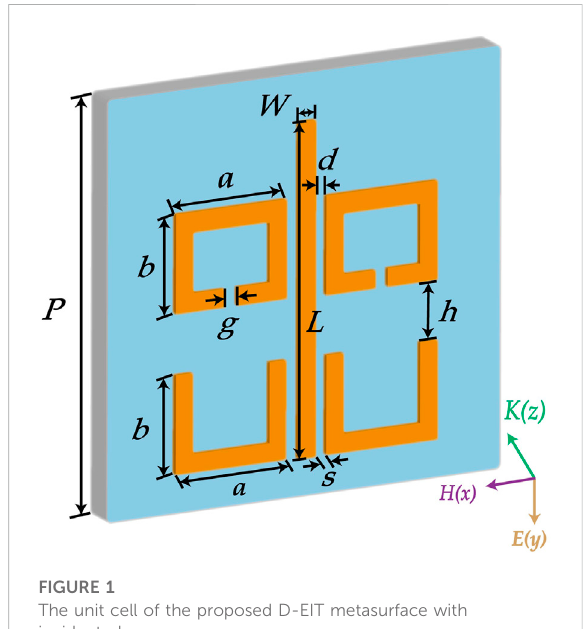
FIGURE 1 The unit cell of the proposed D-EIT metasurface with incident plane